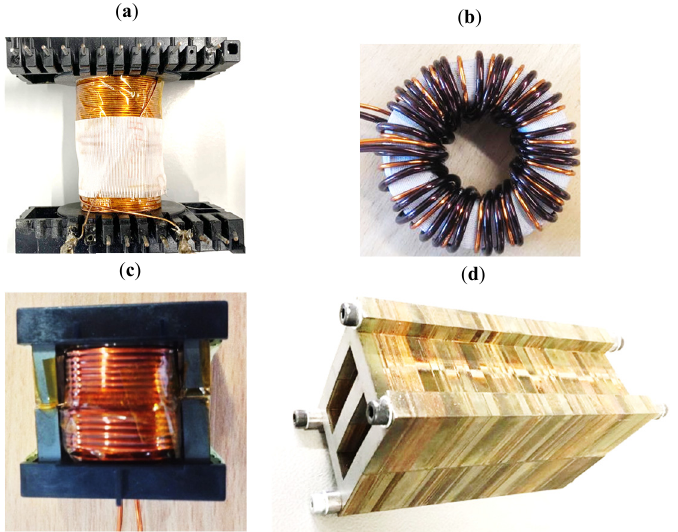
Figure 5. Layout of Traditional Inductor ( a ) Air core Inductor wound on Plastic Bobbin ( b ) Toroidal Core Inductor ( c ) Single Phase Solid EE-core Inductor with bobbin and metal bracket ( d ) EE shaped Laminated Core cut through EDM.